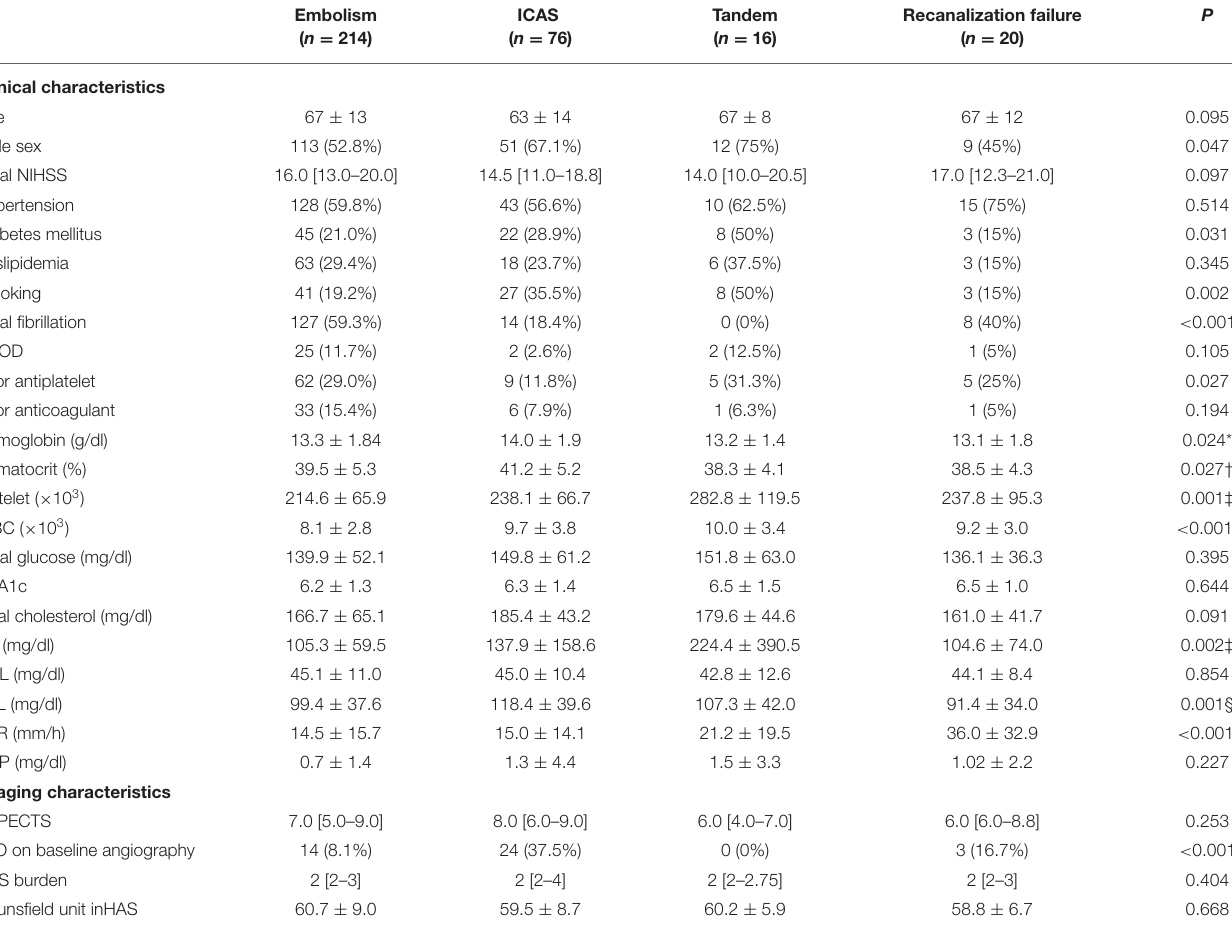
TABLE 1 | Baseline characteristics and risk factors of the four etiologic groups.